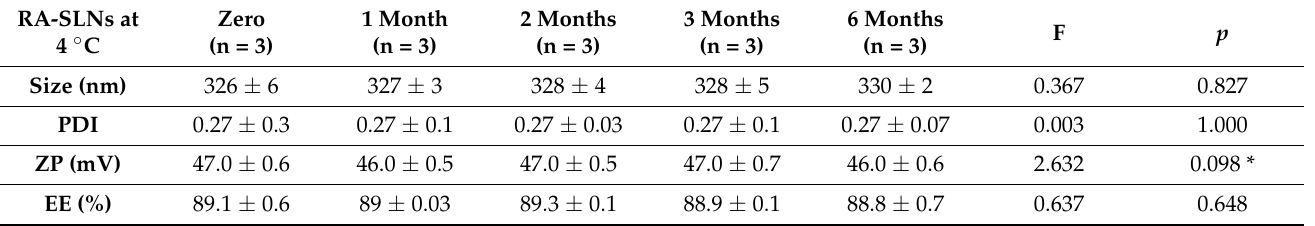
Table 1. Physicochemical properties of RA-SLN suspensions after storage at 4 ◦ C for the studied du-